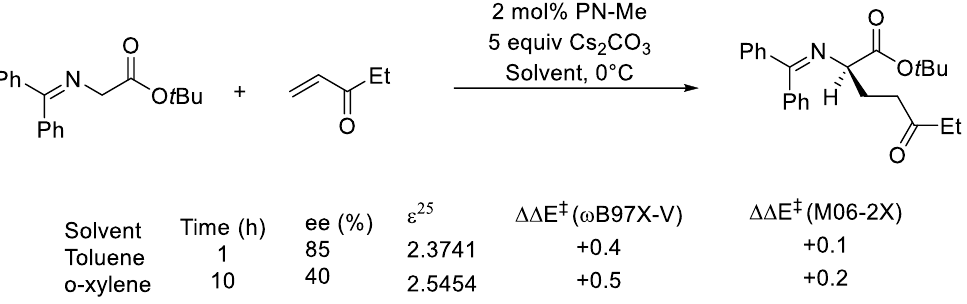
Figure 19. Pentanidium-catalyzed asymmetric conjugate addition. Experimental values are from the work of Tan and his co-workers [146]. ω B97X-V/def2-TZVPP and M06-2X/6-31+G(d,p) values included SMD solvation calculated with structures from Kee and Wong [166].